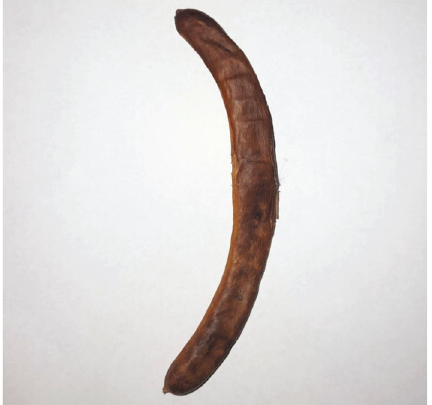
Figure 1: Mesquite used in this